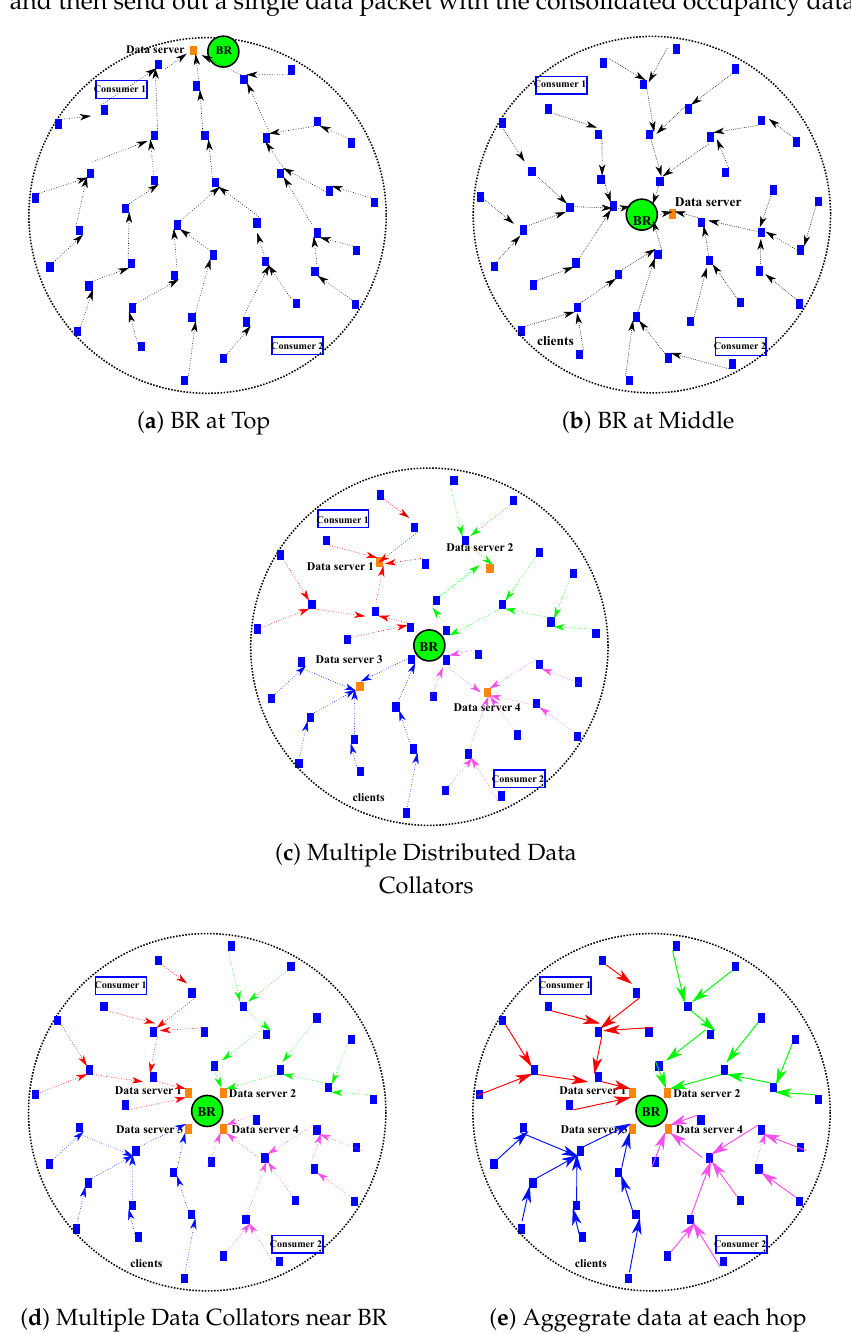
Figure 6. Flow of occupancy data ( a ) BR with one data collator at top. ( b ) BR with one data collator in middle ( c ) BR with four distributed data collators ( d ) BR with four data collators near BR. ( e ) Routers aggregate occupancy data at each hop.